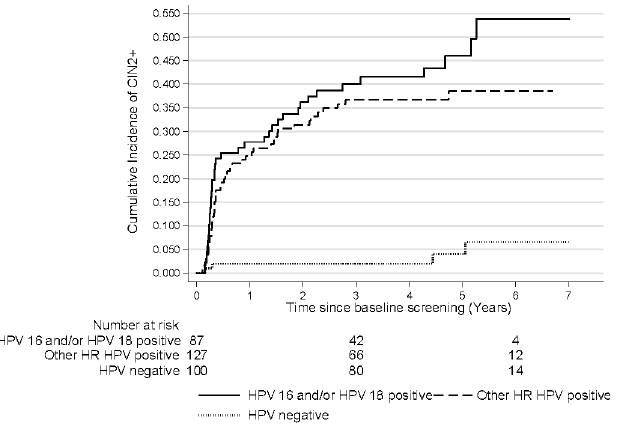
Fig 3. Cumulative incidence of CIN2+ by baseline HR HPV status. CIN2+: cervical intraepithelial neoplasia grade 2 or worse, HR HPV: high-risk human papillomavirus. Log rank p-value: < 0.0001